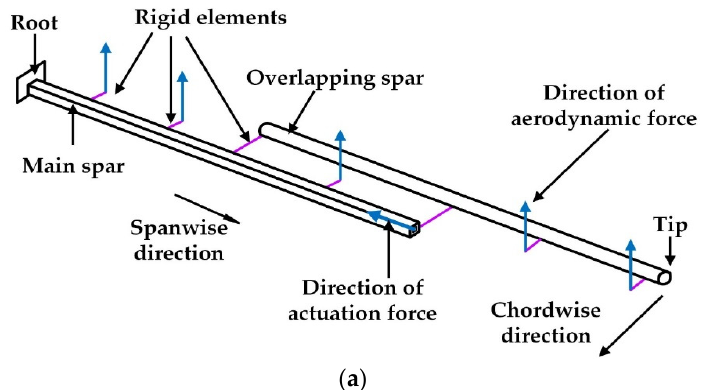
Table 2. Variation in RBM due to passive pitching mechanism.